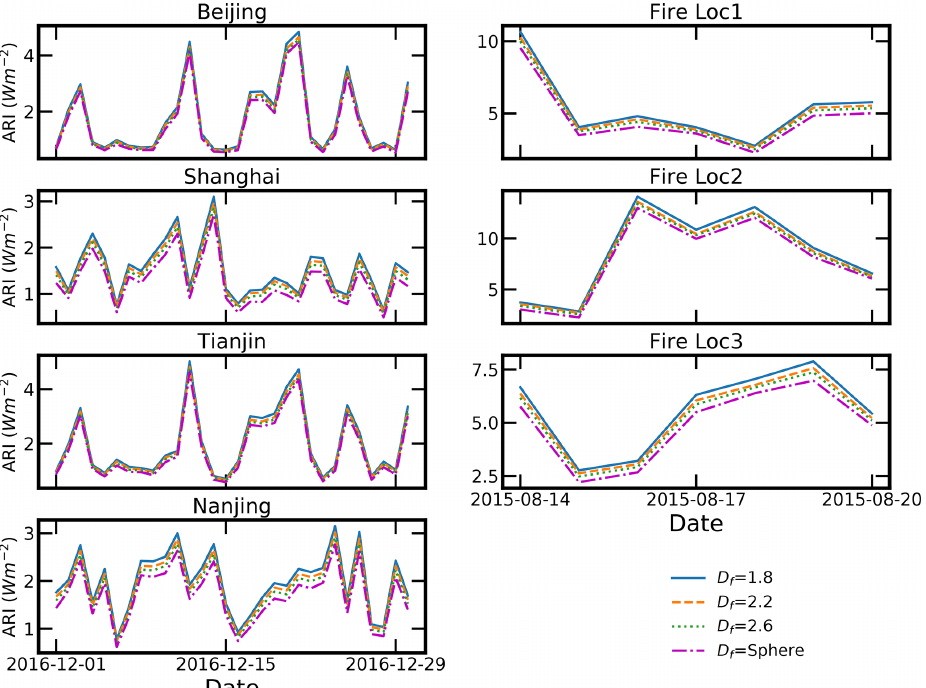
Figure 12. The clear-sky BC ARI in the typical urban polluted cities in eastern China and fire sites in the northwest US calculated using different BC models.